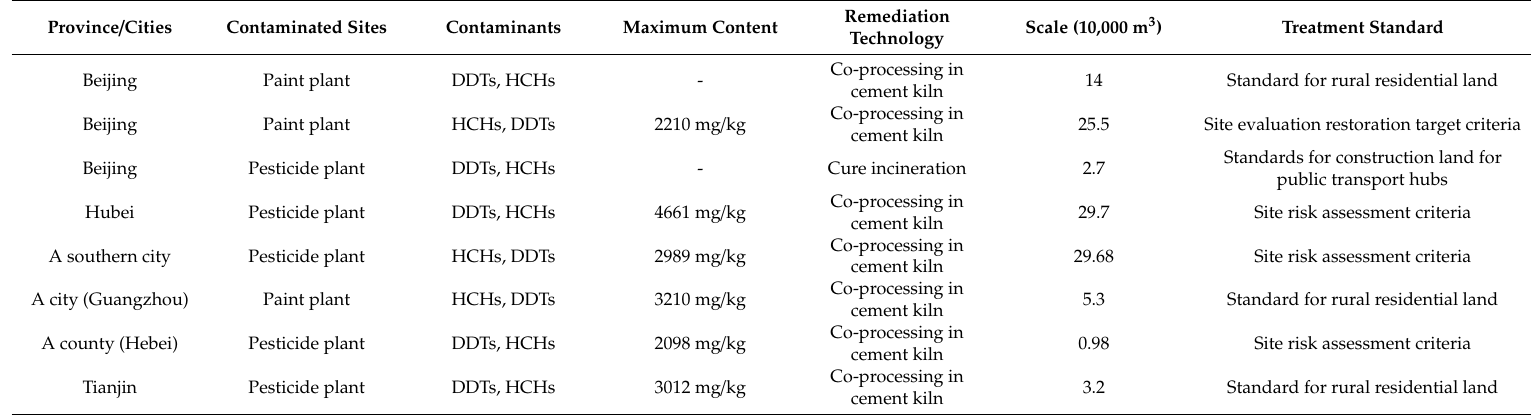
Remediation projects of POPs-contaminated sites in China. POPs: persistent organic pollutants; DDTs: dichlorodiphenyltrichloroethanes; HCHs: